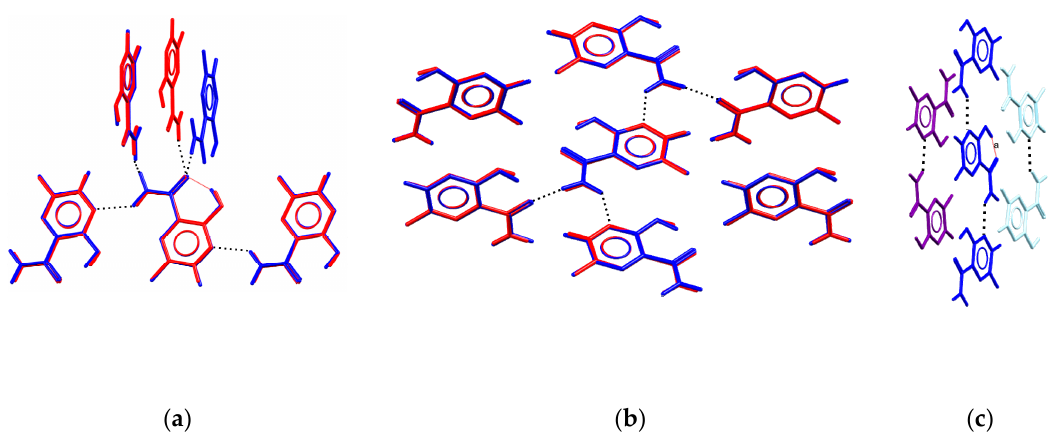
Figure 3. ( a , b ) Comparison of local environment of favipiravir in orthorhombic (red) and tetragonal (blue) polymorphs. ( c ) Side view of parallel motifs in the tetragonal polymorph of favipiravir. H-bonds are shown with dashed lines.